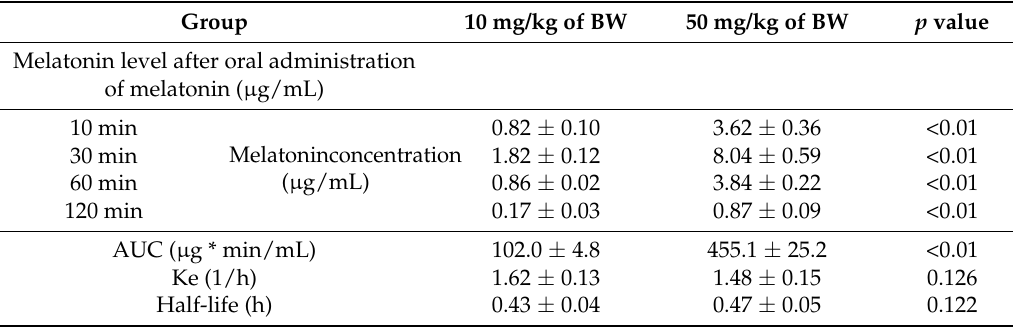
Table 8. Pharmacokinetics of